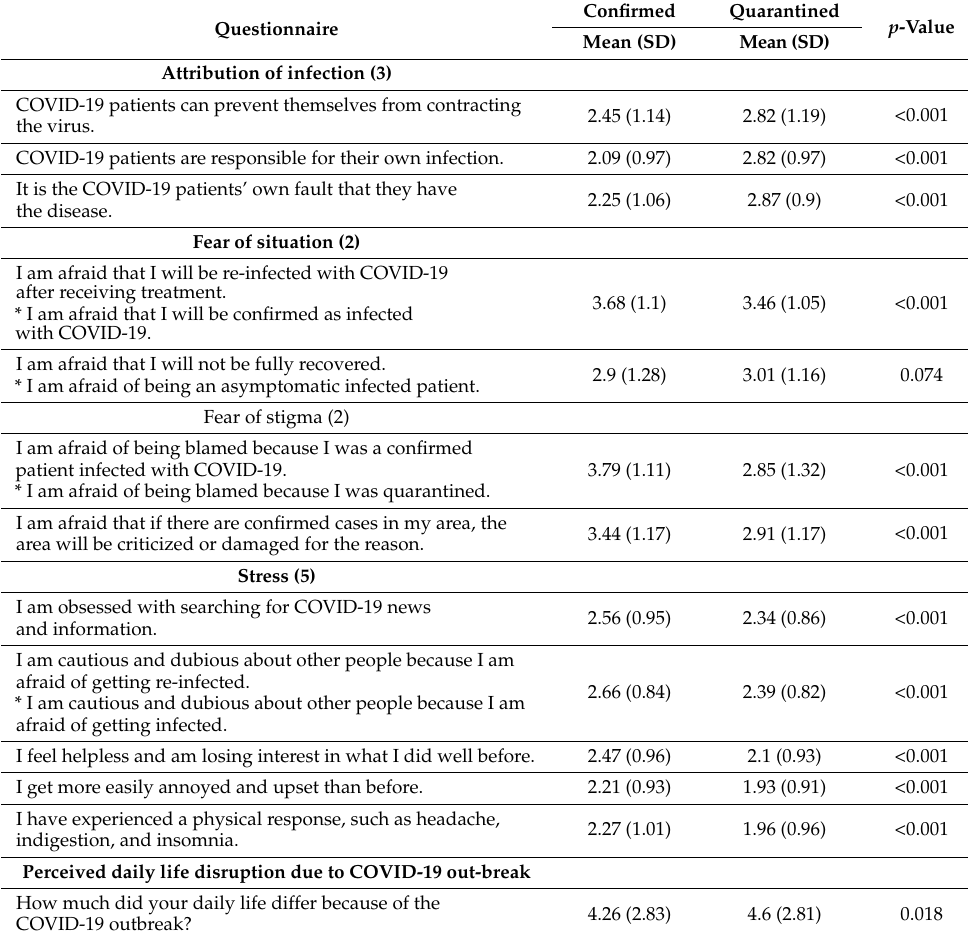
Table 5. Psychological survey response